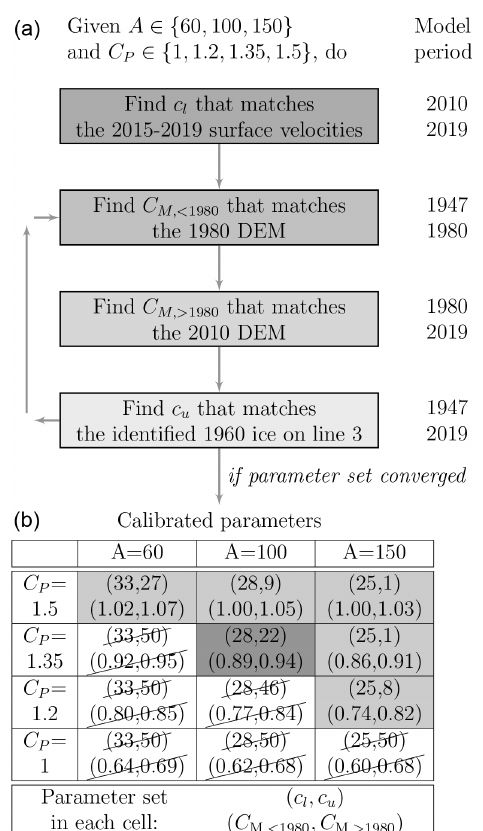
Figure 4. Calibration scheme (a) used in this study to find opti- mal parameters c l , c u , C M ,< 1980 and C M ,> 1980 , for given A and C P parameters, and parameter sets obtained after calibration (b) . In practice, a very few iteration loops over the steps were sufficient to achieve convergence. The grey cells correspond to the parameter sets that were kept for analysis – the strike-through ones being dis- carded for yielding unrealistic results (Sect. 4.3). The dark grey cell indicates the closest to the mean of the six retained parameters and was taken as the best-guess parameter